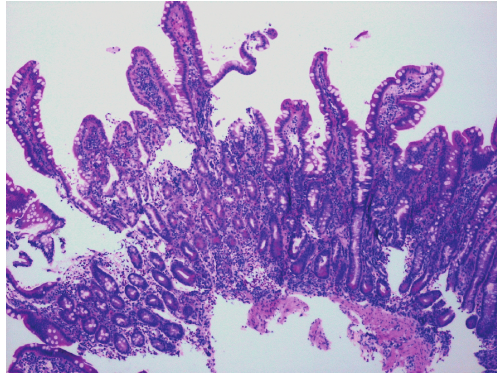
Figure 2: Clinical picture of palpable purpura involvement of bilateral upper extremities.